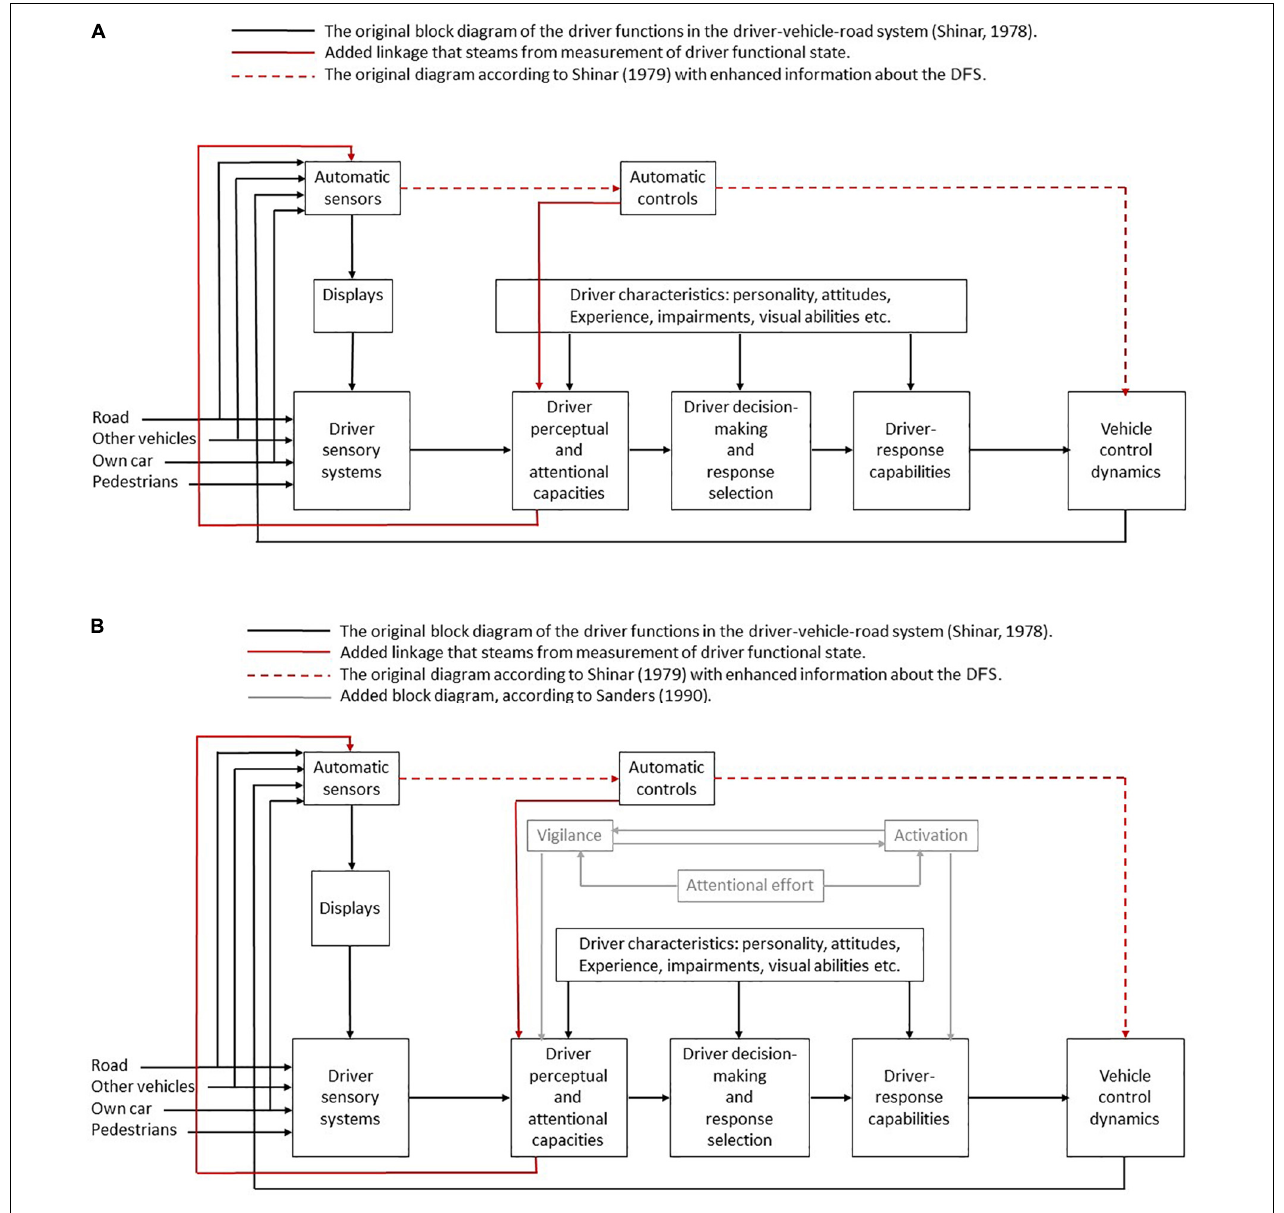
FIGURE 4 | (A) A limited-capacity model of driver information processing (adapted from Shinar, 1978) with added paths for DFS. Reproduction with permission of the author. (B) A hybrid limited-capacity model of driver information processing paths for DFS (adapted from Shinar, 1978 and Sanders et al., 1990). Here, we integrate all the factors that are supposed to make the DFS varying. The operations of information processing (perception, attention, memory access, decision making, and motor adjustments) require the mobilization of mental resources (attentional effort) and, thus change the DFS so that the driver is able to drive efficiently and safely. The DFS can be evaluated by a set of physiological and behavioral indices, and adjust as a function of the level of vehicle